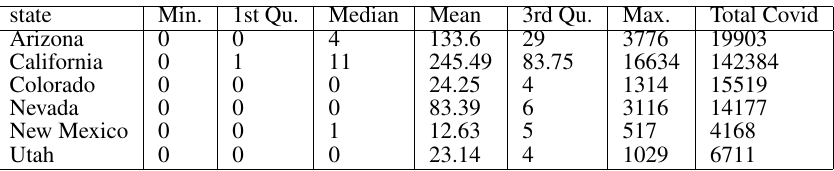
Table 6. Covid-19 Infected Cases in Winter.